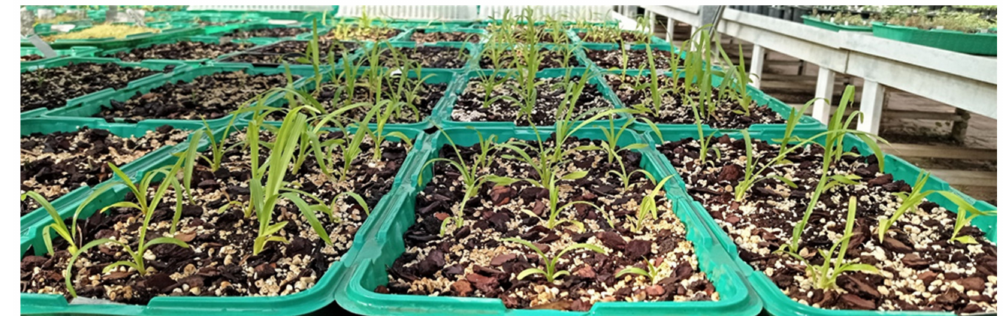
Figure 7. Plantlets of C. erythrostylum growing in containers in